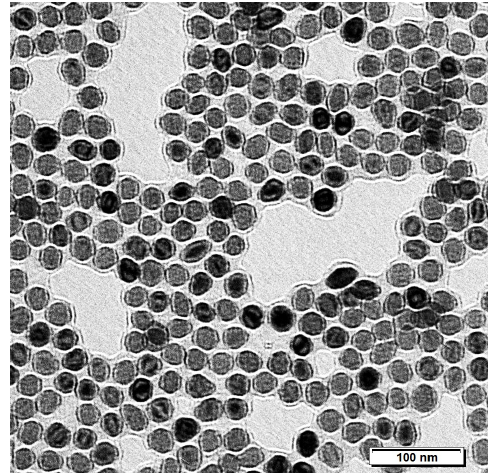
Figure 1. Transmission electron microscope (TEM) figure of polyethylene glycol (PEG)-coated ultra-small superparamagnetic iron oxide nanoparticle (USPION) dispersion. Size of nanoparticles iron core was 29.8 ± 0.2 nm (mean ± standard error of the mean—SEM), and no aggregation of nanoparticles was found.